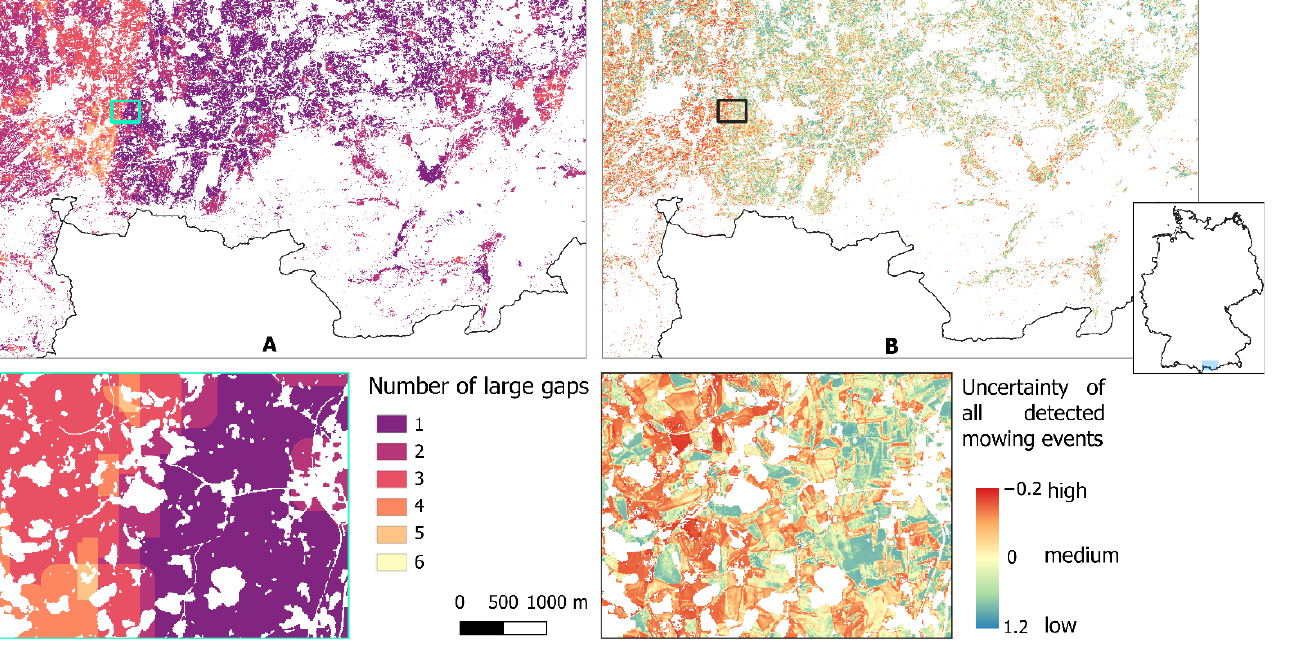
Figure 14. Quality information for the S2 dataset 2019 represented by the number of large gaps ( A ), and uncertainty information of the mowing frequency, estimated from the gradient and data availability of the detected mowing events ( B ) for the focus region (Ammer region) and a zoom region indicated on the map.